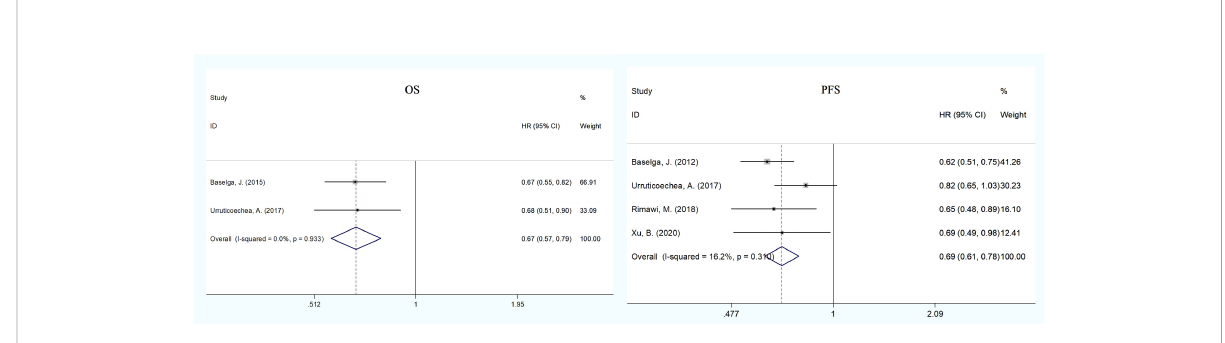
FIGURE 2 Meta-analysis of primary endpoints [overall (OS) and progression-free survival (PFS)] between the dual anti-HER2 therapy group (pertuzumabplus trastuzumab) and the monotherapy group in advanced breast cancer. The size of the squares indicates the weight of the study. Error barsrepresent 95% con fi dence intervals (CIs). The diamond indicates the summary odds